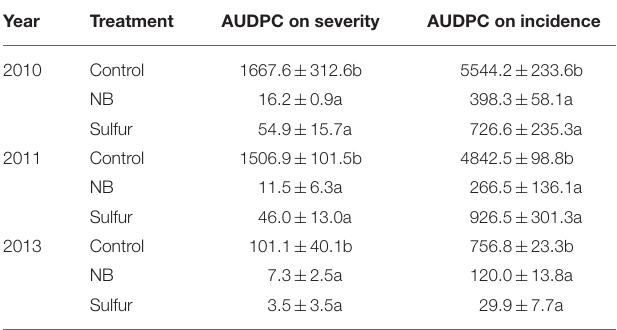
TABLE 1 | Area under the disease progress curve (AUDPC) of grapevine powdery mildew under field conditions.